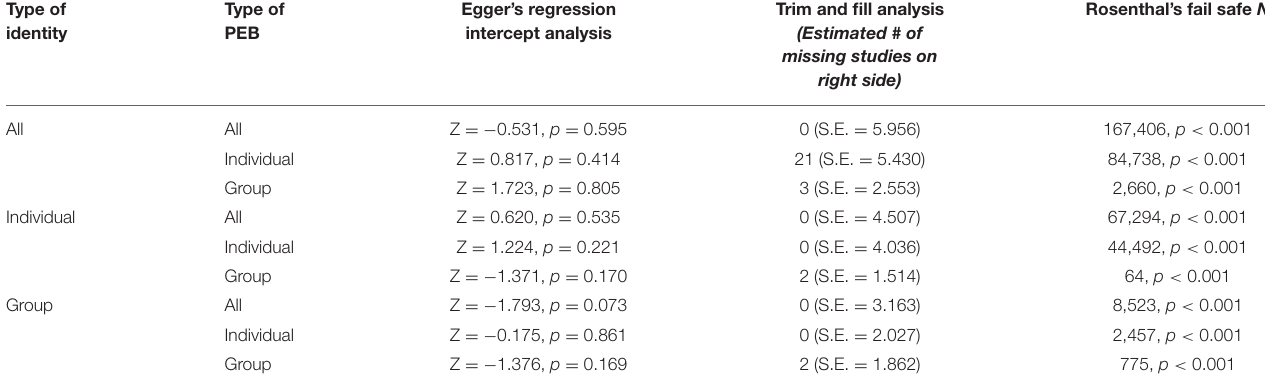
TABLE 4 | Publication bias check of studies using identity types in